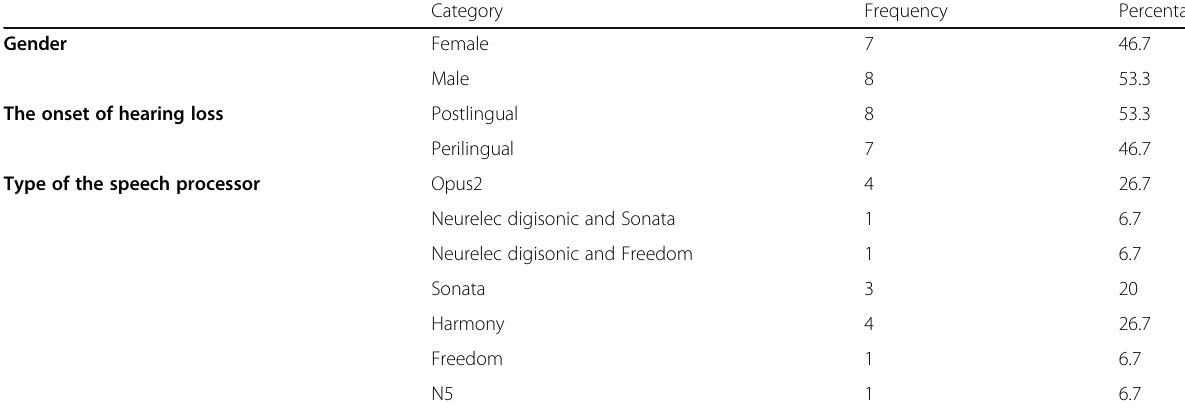
Table 1 Patients ’ descriptive data